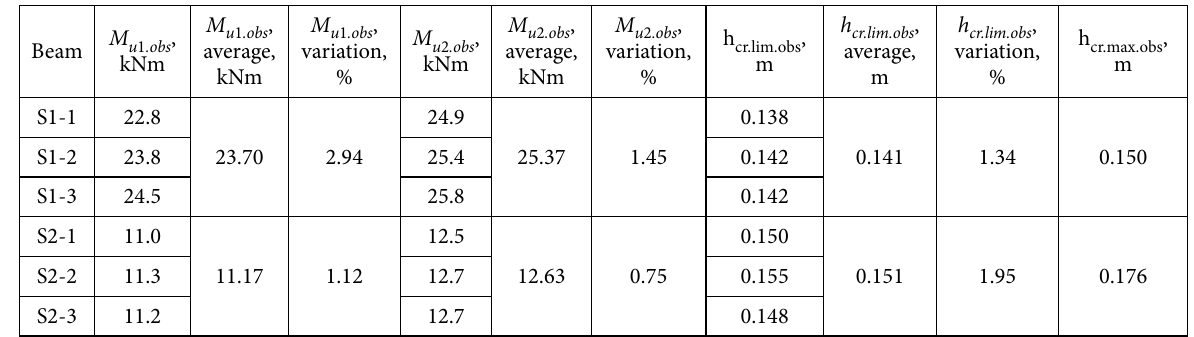
Table 2. Experimental